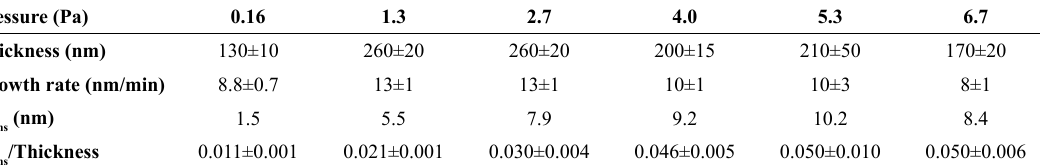
Figure 1. 2 µm x 2 µm AFM images of AZO films produced at different sputtering pressures: (a) 0.16 Pa, (b) 1.3 Pa, (c) 2.7 Pa, (d) 4.0 Pa (e) 5.3 Pa and (f) 6.7 Pa. Table 1. Thickness, growth rate, RMS roughness and roughness/thickness ratio for AZO thin films. The RMS roughness of glass is about 0.3 nm.